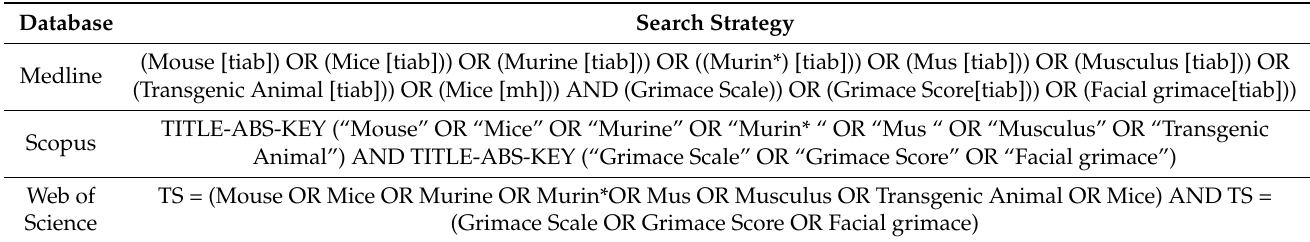
Table A1. Search Strategy. Search conducted on 4th May